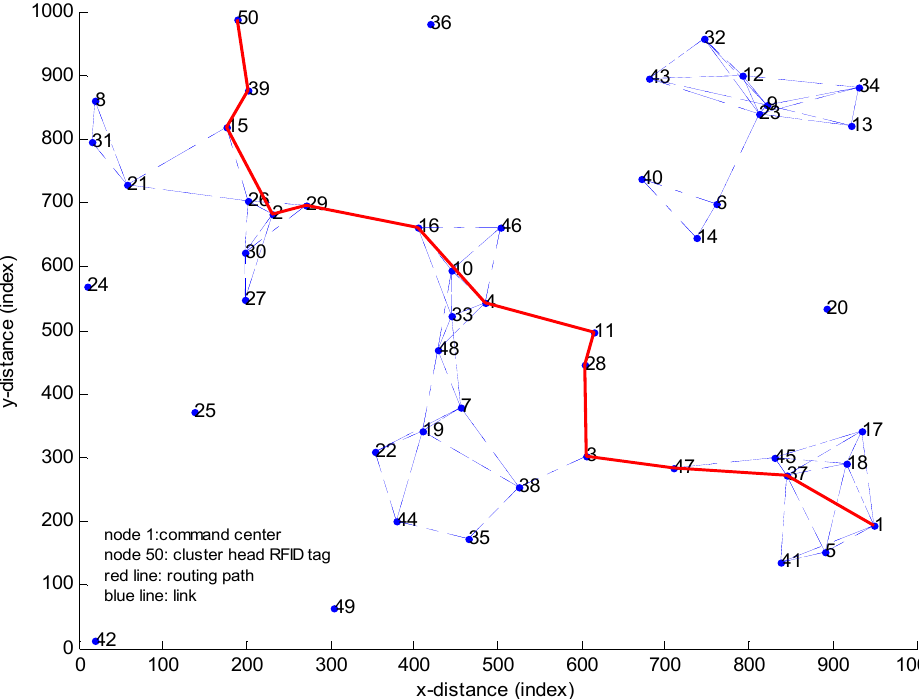
Figure 16. Routing path in example